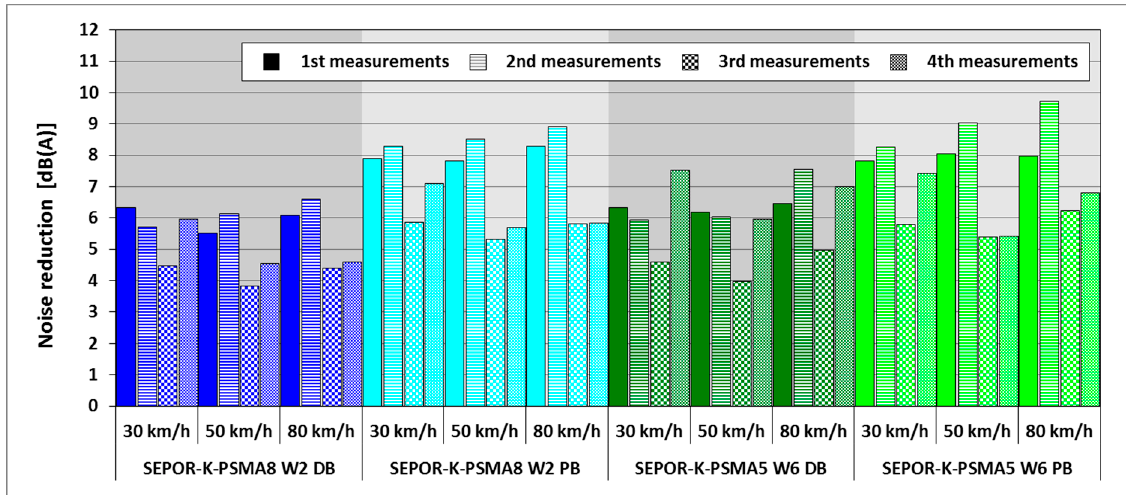
Figure 25. Noise reduction of poroelastic mixtures on the Kartoszyno long test section.